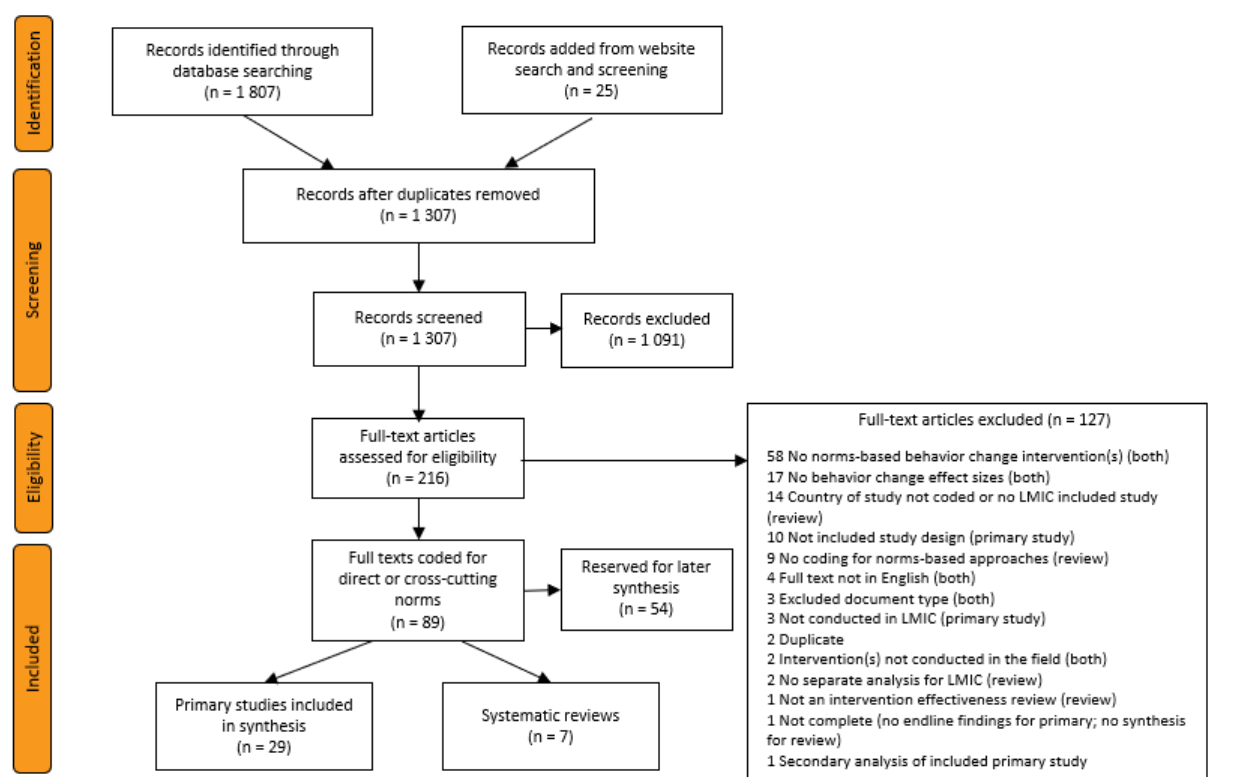
Figure 2. PRISMA flow diagram of search and screening results.